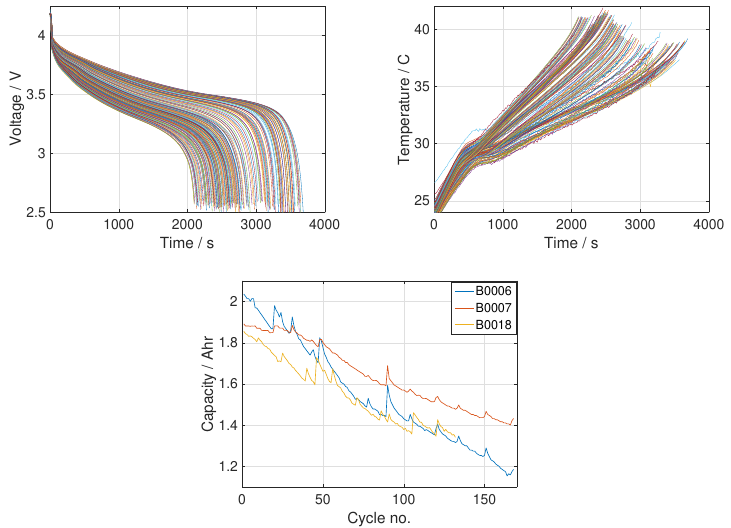
Figure 1. The temperature and voltage for B0006 after interpolation and the measured capacity for all batteries